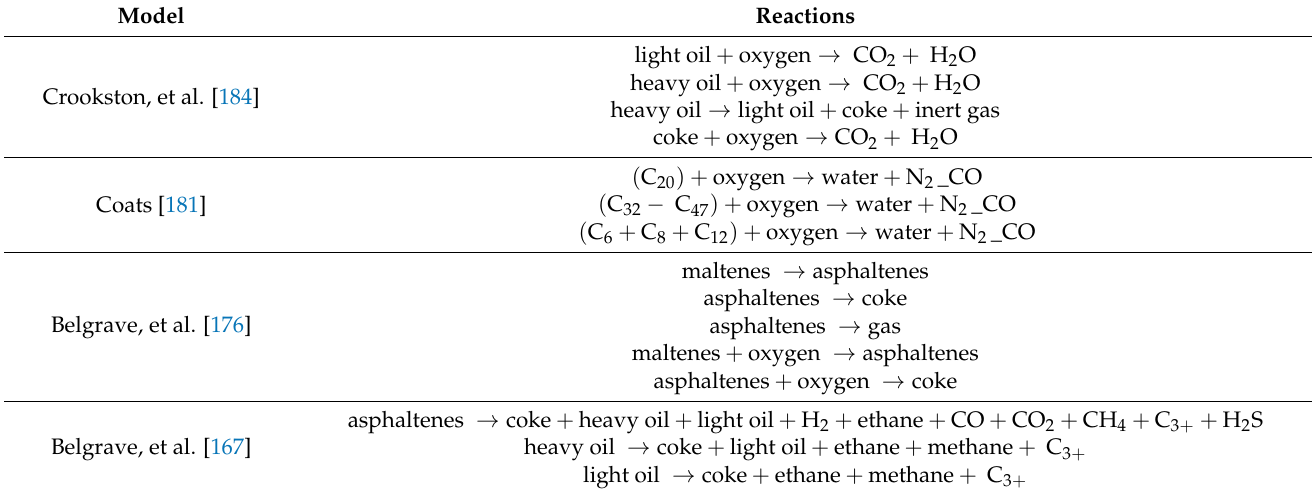
Table 3. Table to show different reaction schemes used for modelling of in-situ